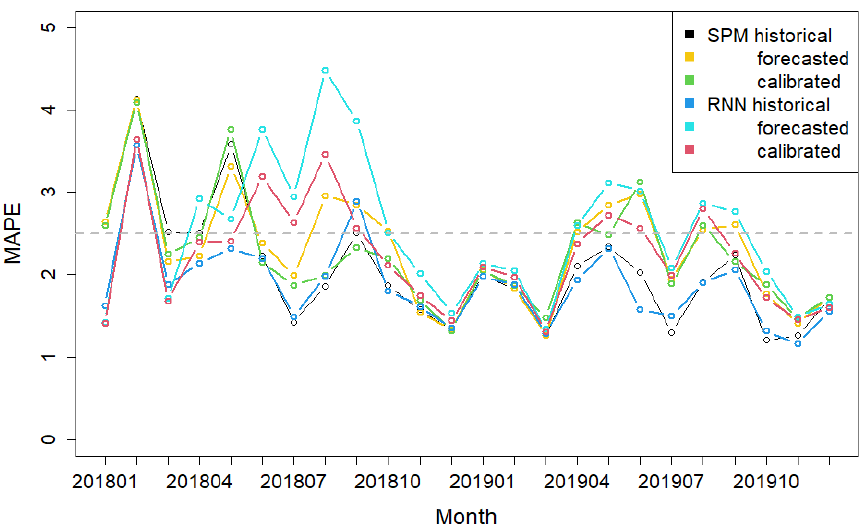
Figure 5. The mean absolute percentage errors (MAPEs) of semi-parametric (SPM) and RNN models with the historical, forecasted and calibrated temperatures for the ( D + 1)-day daily load pat- terns. Table 3. Performance Comparisons on mean absolute percentage errors (MAPEs) of semi-parametric (SPM) and RNN Models with the Historical, Forecasted and Calibrated Temperatures, for the next ( D + 1)-day Load Patterns.